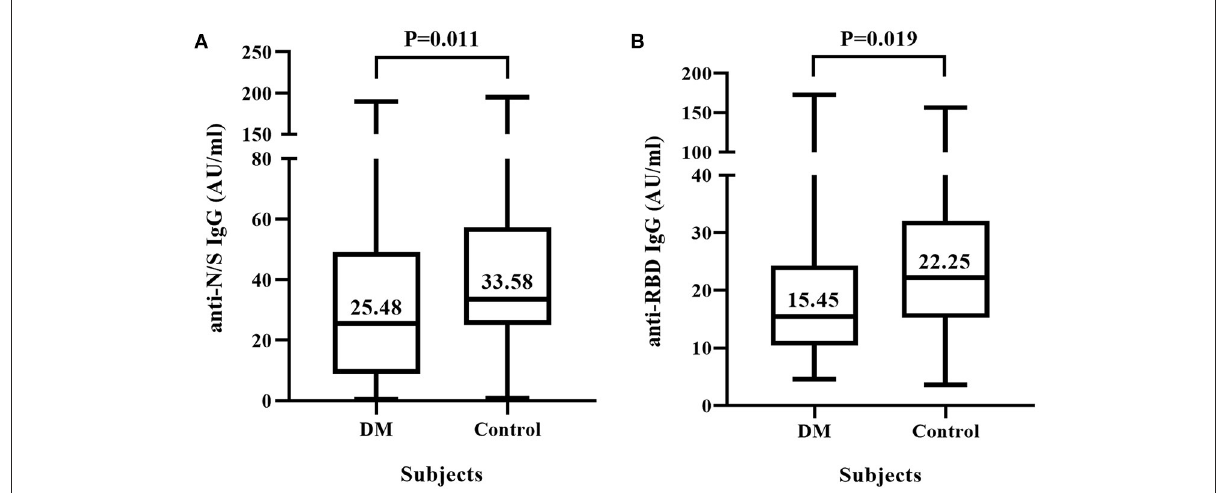
FIGURE1 IgG antibody response to inactivated COVID-19 vaccine in diabetic mellitus (DM) patients and non-DM controls. Sixty-three DM patients and 56 non-DM subjects were each vaccinated with two doses of COVID-19 vaccine composed of inactivated SARS-CoV-2. (A) Titers of IgG antibody against the nucleocapsid (N) and spike (S) proteins of SARS-CoV-2 (anti-N/S IgG). (B) Titers of IgG antibody against receptor binding domain (RBD) of S protein (anti-RBD IgG).